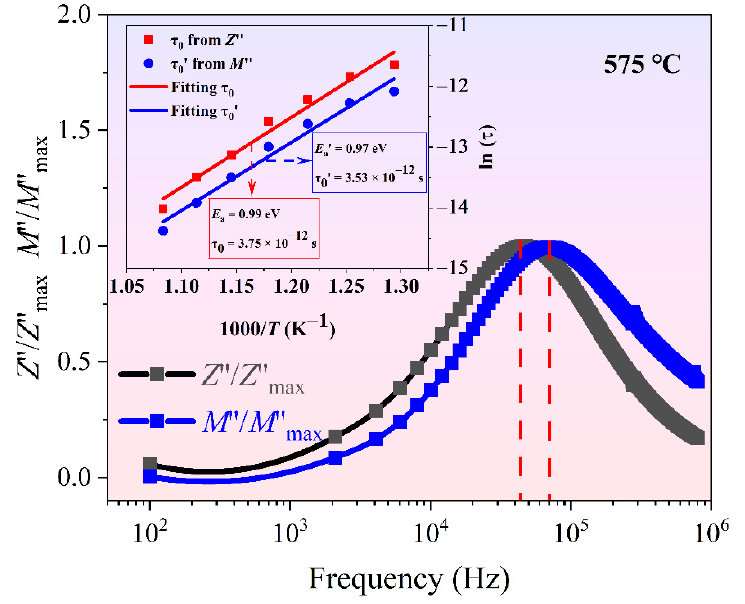
Figure 8. Comparison between Z ″ / Z ″ max peak and M ″ / M ″ max peak for the BGTN − 0.2Cr ceramic (inset shows the Arrhenius fitting of the plots of relaxation time vs. temperature).